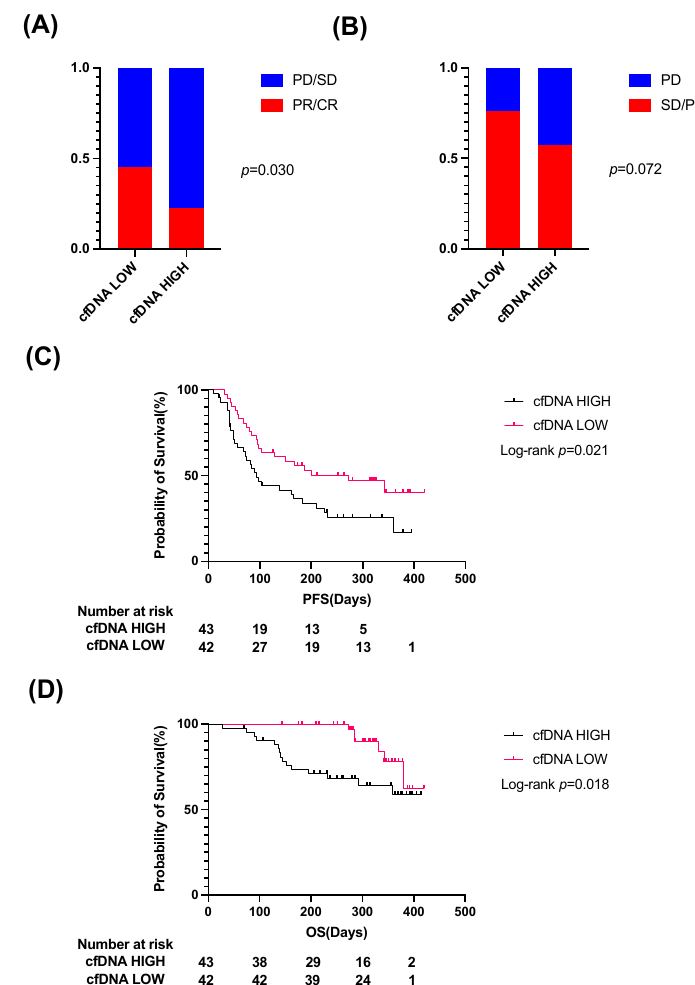
Figure 2. Patients with high plasma cfDNA levels show significantly lower ORR and shorter PFS and OS than those with low cfDNA levels. The baseline cfDNA level was quantified for 85 u-HCC patients treated with Atezo/Bev. The patients were classified into two groups according to the median value of plasma cfDNA level. ( A , B ) The best overall response rate (ORR) ( A ) and disease control rate (DCR) ( B ) in each group. ( C , D ) The Kaplan–Meier curves of progression-free survival (PFS) ( C ) and overall survival (OS) ( D ) for each group. cfDNA, cell-free DNA; u-HCC, unresectable hepatocellular carcinoma; Atezo/Bev, Atezolizumab and bevacizumab; CR, complete response; PR, partial response; SD, stable disease; PD, progressive disease.